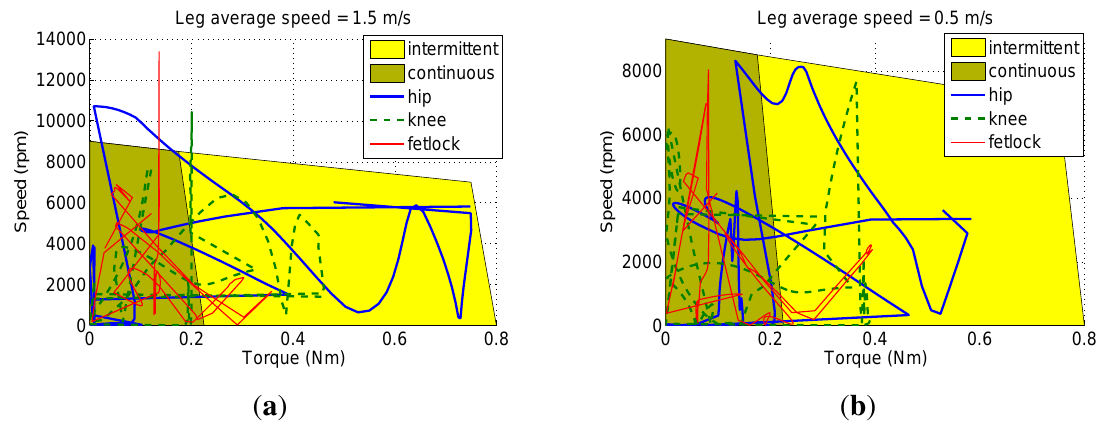
Figure 13. Motor torque-speed diagram and joint requirements for the real leg prototype manufactured in Aluminium 7075 ( a ) average leg speed of 1.5 m/s; ( b ) average leg speed of 0.5